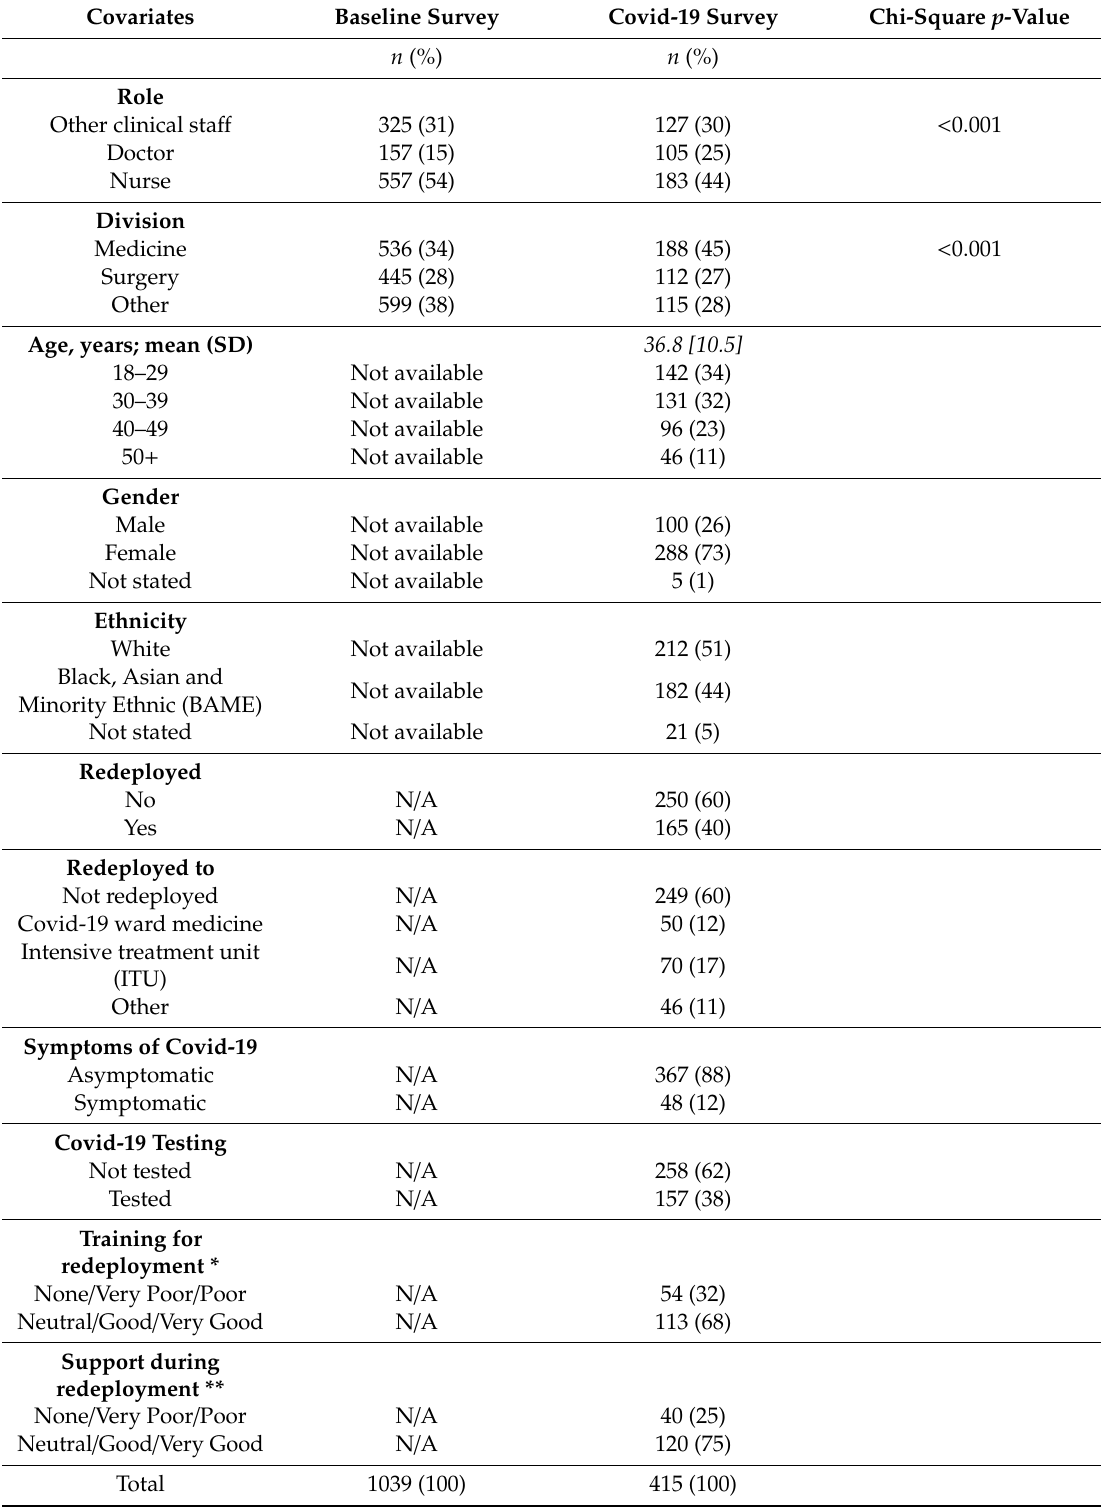
Table 1. Respondent